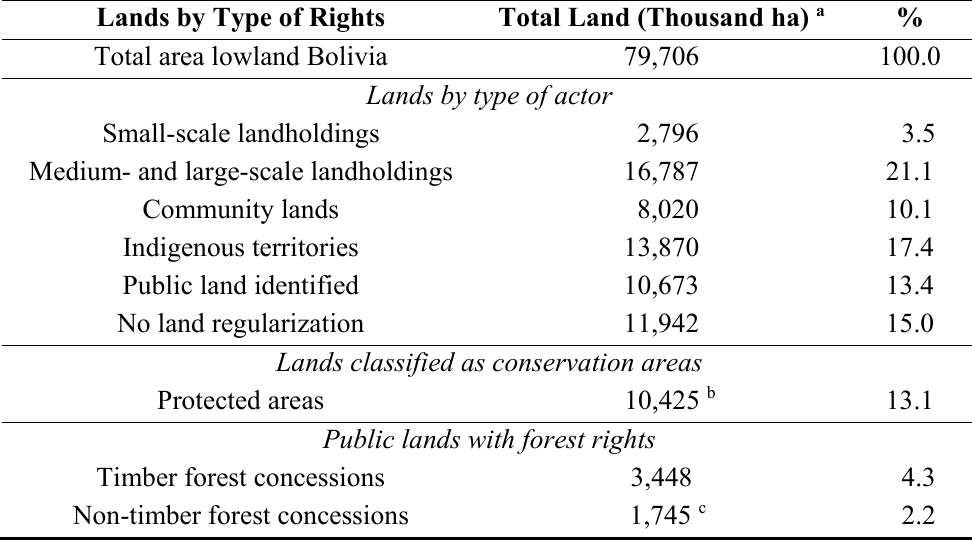
Table 2. Land tenure and forest rights in lowland